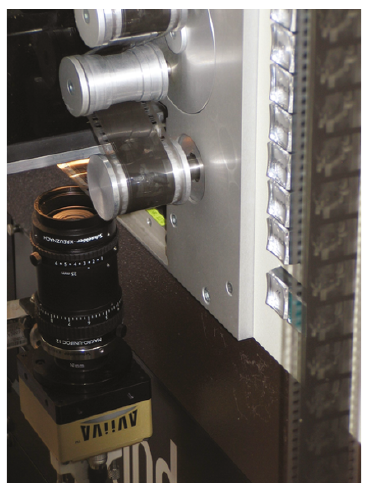
Figure 5: Close shot of our specific scanner, showing the line-scan camera and